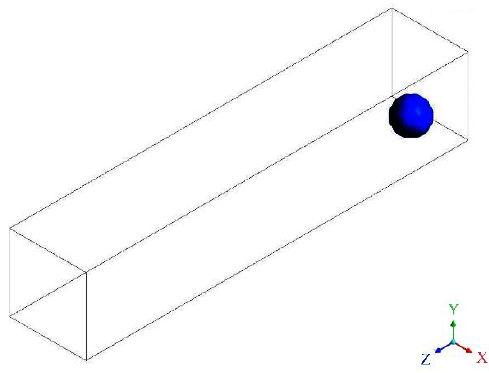
Figure 1. A straight channel with a water droplet initialized at the inlet.